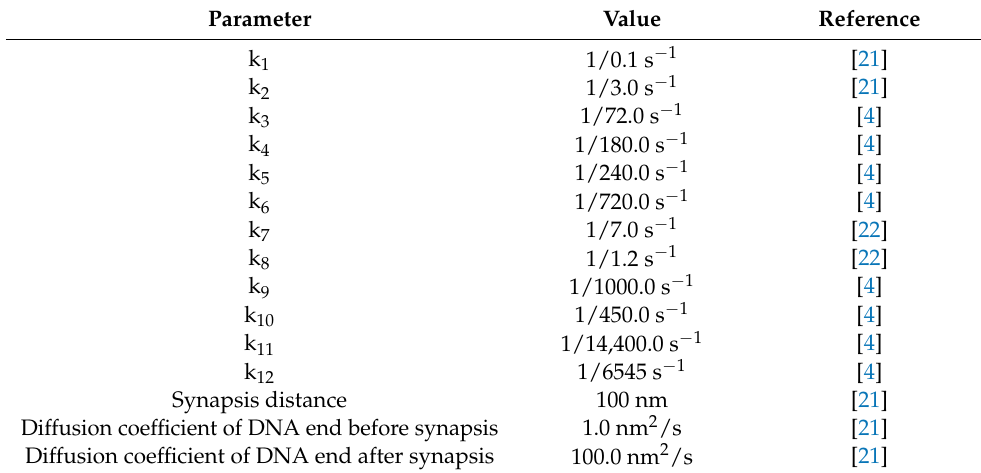
Table 1. Parameters of the DNA repair